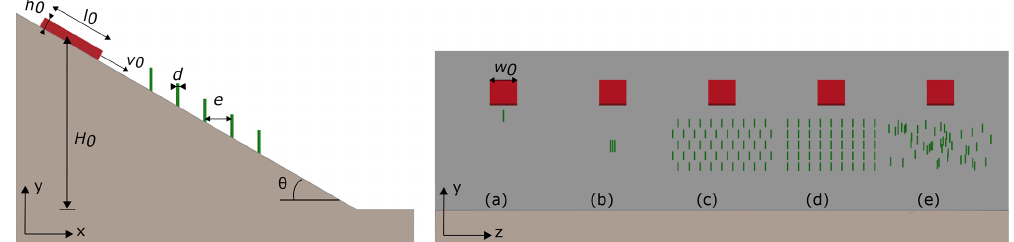
Figure 1. Model setup of MPM simulations of snow avalanches impacting trees. The left and right are side and front views respectively. Five arrangements of trees in the right include (a) one tree, (b) three trees, (c) regularly staggered trees, (d) regularly aligned trees, and (e) random